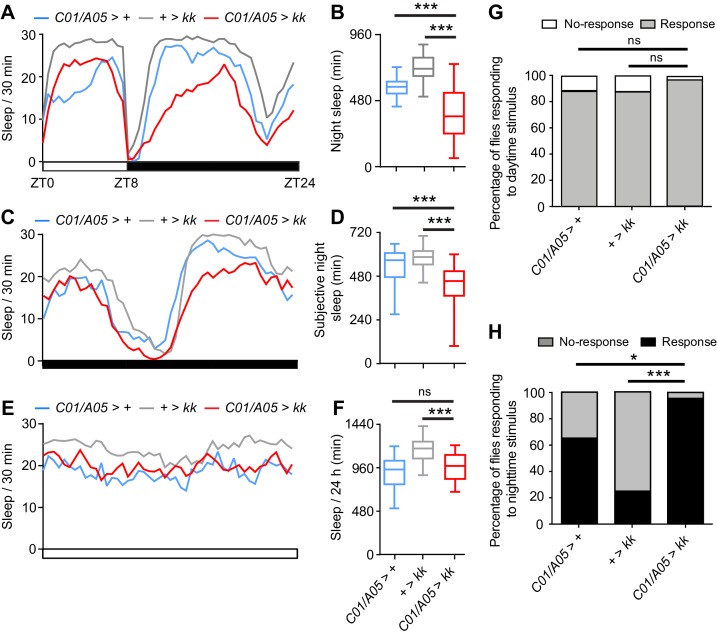
NCA acts in a two distinct neural subpopulations to regulate night sleep.(A–F) Sleep patterns in adult male flies with Nca knockdown (using the kk Nca RNAi) in two neural domains defined by the A05- and C01-Gal4 drivers in varying light/dark regimes, compared to controls. (A–B) A: mean sleep patterns in 8L: 16D conditions. B: median night sleep in Nca knockdown flies compared to heterozygote drivers and transgene alone controls. + > kk: n = 80; C01/A05 > +: n = 42; C01/A05 > kk: n = 71. (C–D) Mean sleep patterns (C) and median subjective night sleep (D) in constant dark (DD) conditions. + > kk: n = 64; C01/A05 > +: n = 47; C01/A05 > kk: n = 51. (E–F) Mean sleep patterns (E) and median total sleep (F) in constant light (LL) conditions. + > kk: n = 76; C01/A05 > +: n = 26; C01/A05 > kk: n = 28. (G–H) Percentage of C01/A05 > kk and control flies responding or not responding to vibration stimuli at either ZT4 (G; C01/A05 > kk, n = 38, + > kk, n = 61 and C01/A05 > +, n = 26) or ZT16 (H; C01/A05 > kk, n = 24, + > kk, n = 54 and C01/A05 > +, n = 28) under 8L: 16D conditions. ns – p>0.05, *p<0.05, **p<0.01, ***p<0.001, compared to driver and RNAi alone controls, Kruskal-Wallis test with Dunn’s post-hoc test (B, D, F) or Binomial test with Bonferonni correction for multiple comparisons (G–H).10.7554/eLife.38114.019Figure 4—source data 1.Sleep levels and proportion of flies responding to mechanical stimuli following Nca knockdown in C01- and A05-neurons or other specific neuronal subtypes, relating to Figure 4 and associated figure supplements.Blank cells represent data from dead flies removed prior to analysis.